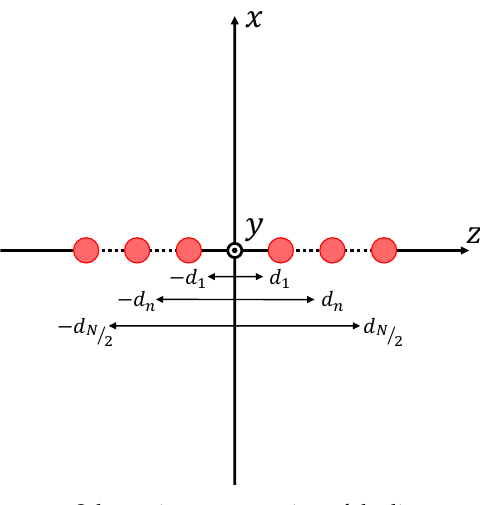
Figure 2. Schematic representation of the linear